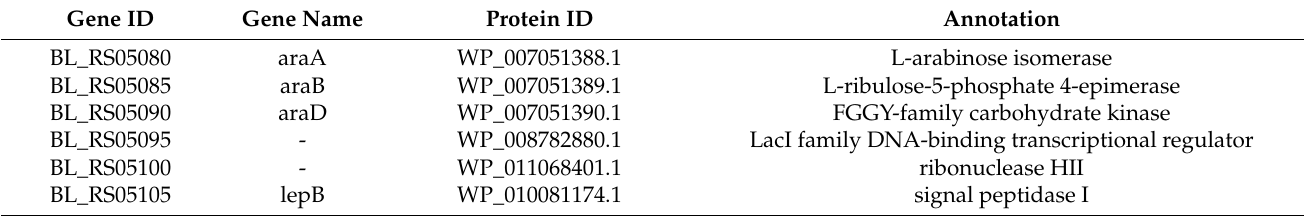
Table 3. Arabinose metabolism gene clusters of B. longum subsp. longum